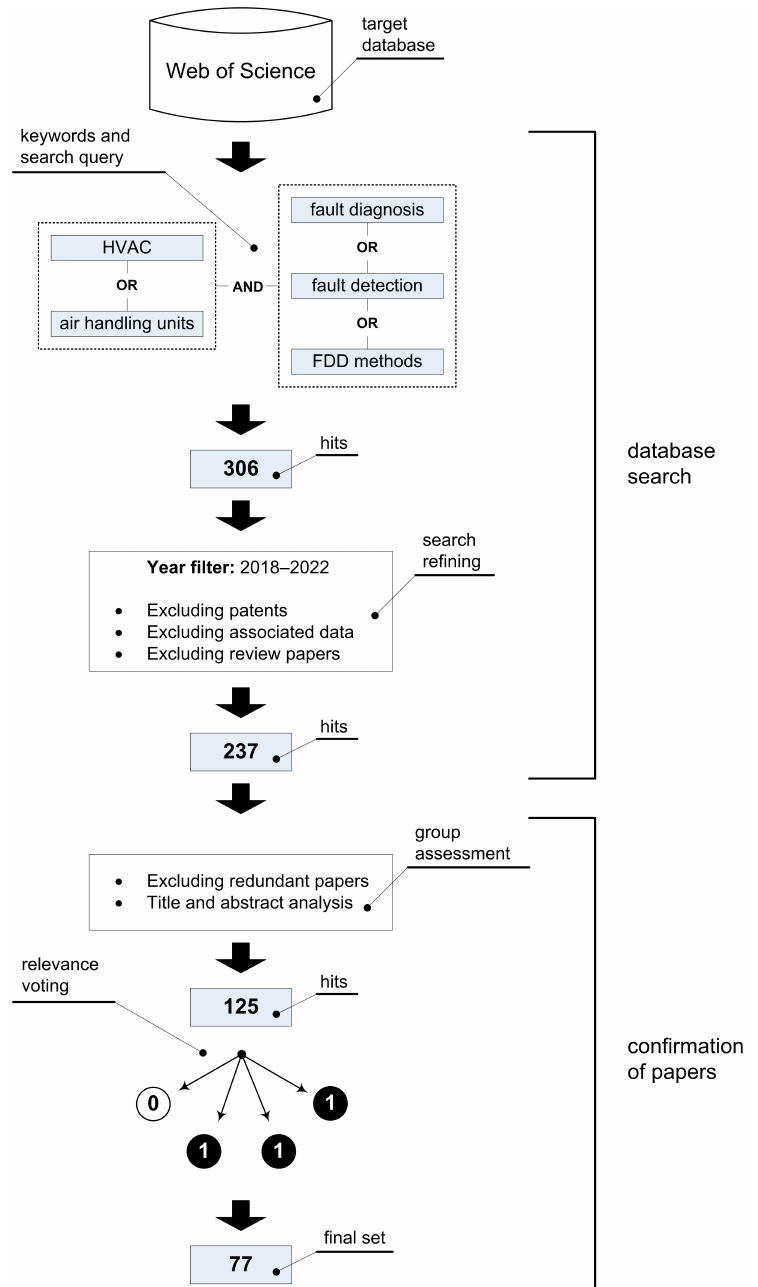
Figure 1. Workflow for collecting the